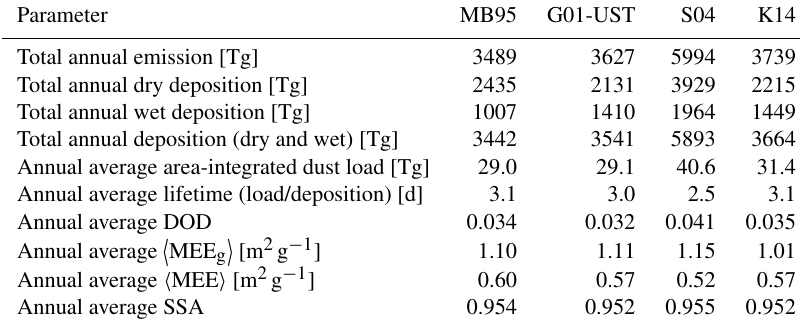
Table 7. Statistical dust parameters of four global model simulations using the dust emission schemes MB95, G01-UST, S04, and K14 with the configurations described in Sect. 4.2. (cid:10) MEE g (cid:11) and (cid:104) MEE (cid:105) are annual global averages of MEE (all sizes). (cid:10) MEE g (cid:11) is calculated as the ratio of annual average grid-based DOD and dust load, whereas (cid:104) MEE (cid:105) is calculated from annual global average DOD and dust load. Parameters are for dust with particle diameters up to